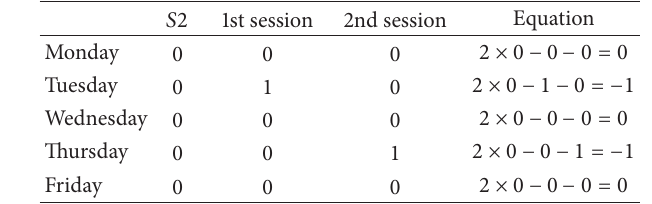
Table 3: 𝑆1 : variable equals 0.